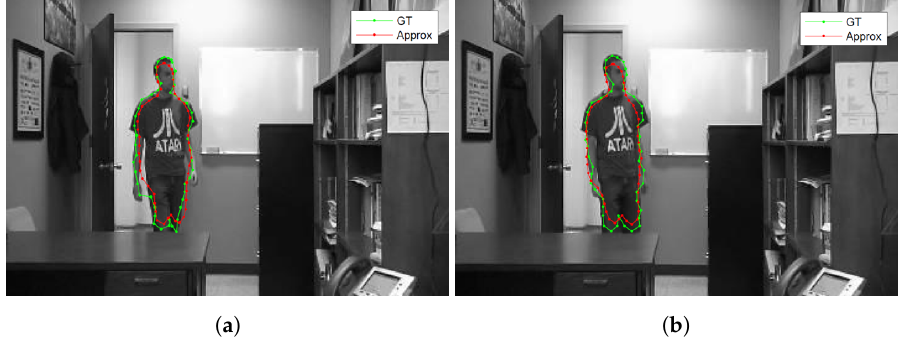
Figure 9. Detection of a pedestrian in selected frames of the CDnet2014 office scene. “GT” represents the manually marked landmarks, and “Approx” shows the estimated landmarks. ( a ) Frame 630;